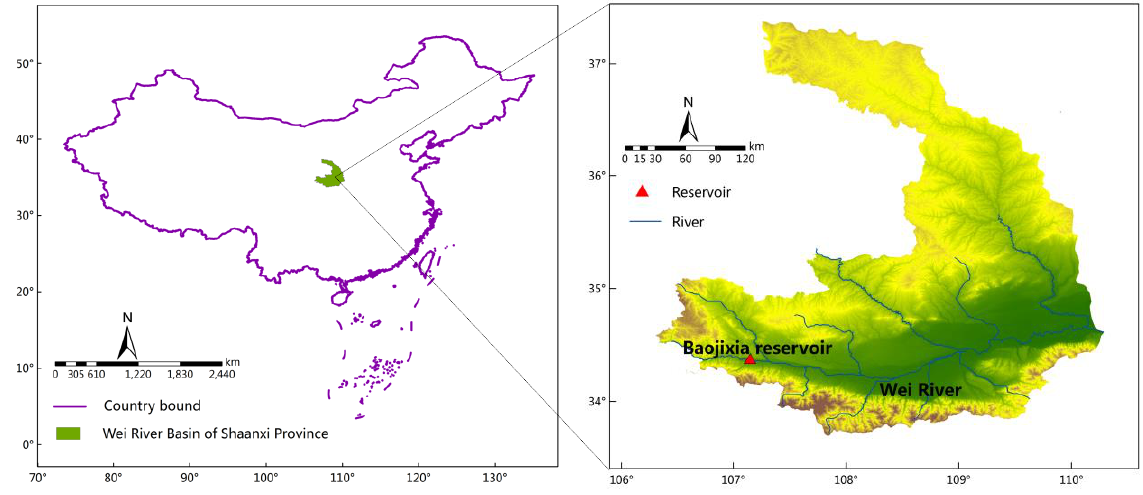
Figure 1. Location of the Baojixia Reservoir. Baojixia Reservoir, as a key water conservancy project in Shaanxi Province, is